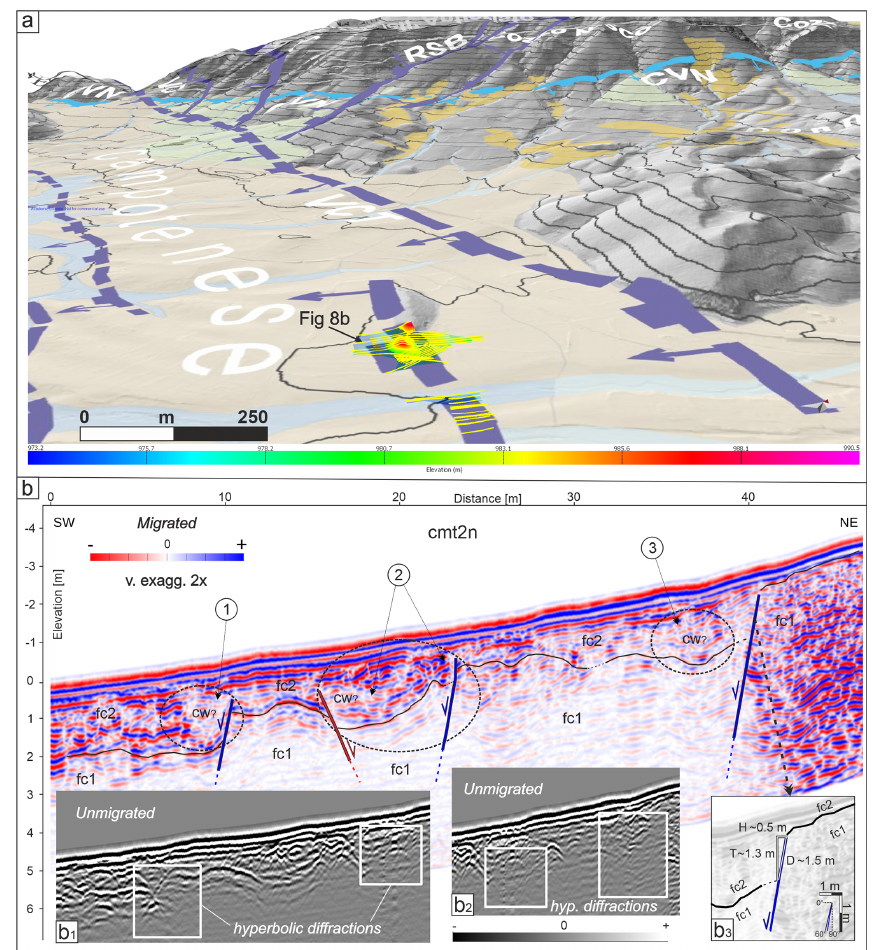
Figure 8. GPR data interpretation: (a) three-dimensional image of the surveyed area (see Fig. 1c for location), displaying the dolostone out- crops (grey color). Blue dashed lines are the VCT and RSB faults (Fig. 1b), whilst the light blue is CVN fault. In yellow lines the GPR profiles; the colored surface is the interpreted dolostone top reflection (DTM source: Regione Calabria – http://geoportale.regione.calabria.it/opendata, last access: 11 June 2021, under license IODL 2.0. – https://www.dati.gov.it/iodl/2.0/, last access: 11 June 2021); (b) migrated radar profile with the main interpreted normal faults (blue and red are W- and E-dipping structures, respectively) as well as related sedimentary structures within the Quaternary deposits (unmigrated data in b1 and b2); the inset b3 is a schematic representation illustrating the methodology used for extraction of the GPR fault displacement ( D : displacement; T : throw; H : heave). GPR facies fc2 shows semi-continuous and sub-horizontal reflections (Quaternary deposits) onlapping fc1 (Triassic dolostones, black line is the “top”). Circle 1 shows that reflection package thicken- ing and truncation with localized attenuation are likely interpretable as “colluvial-wedge-like” (cw?) features, or deposits from degradation of earthquake fault free-face near the hanging wall ( D ∼ 0 . 6m). In circle 2 fc2 is shown to be more discontinuous, from subparallel to wavy reflections package downlapping the lower top dolostone; the asymmetric, truncated reflection thickening is bounded by two conjugate normal fault strands (east dip D ∼ 0 . 5m, west-dip D = 0 . 4m) displacing both fc1 and fc2. Circle 3 shows a contorted reflection package with limited continuity, displaying thickening, truncation, and distributed attenuation, suggesting colluvial wedge deposits close to the main fault zone ( D ∼ 1 . 5m, inset b3). Vertical exaggeration is